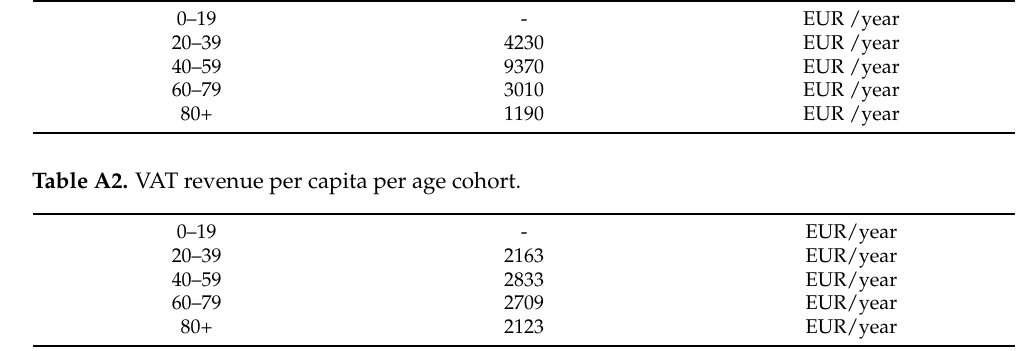
Table A3. Calculated percentage of Long-Covid per age group and severity.